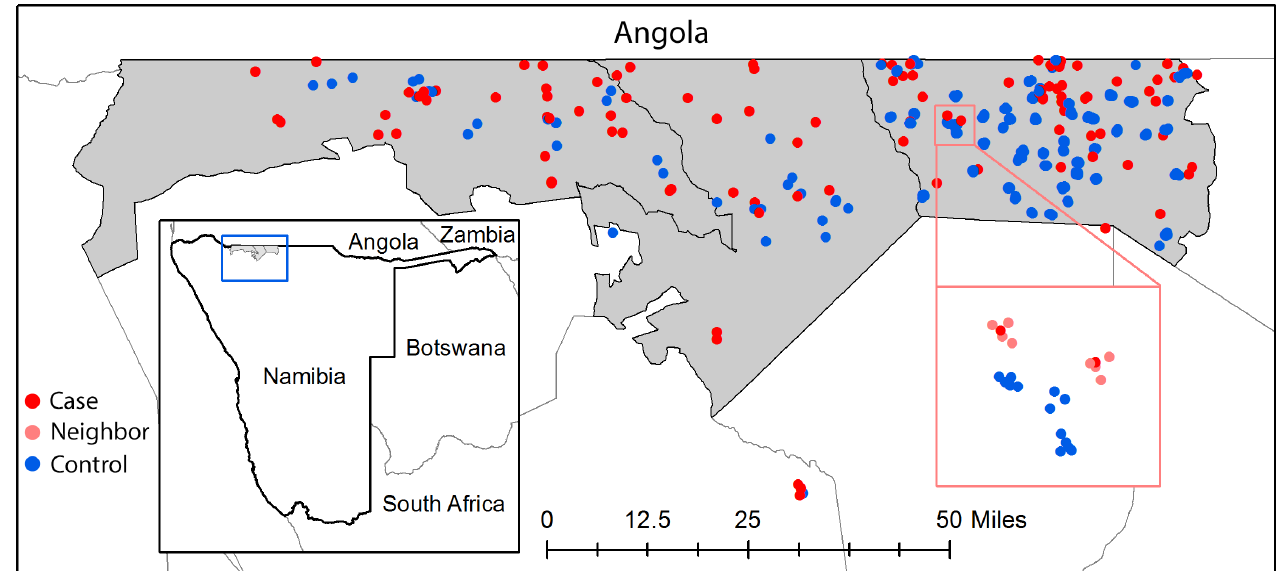
Fig 1. Location of index case (red) and control (blue) households within Engela, Outapi and Oshikuku health district within Namibia. Inset map shows a zoomed view of neighboring households(coral) screenedaroundindex case households.